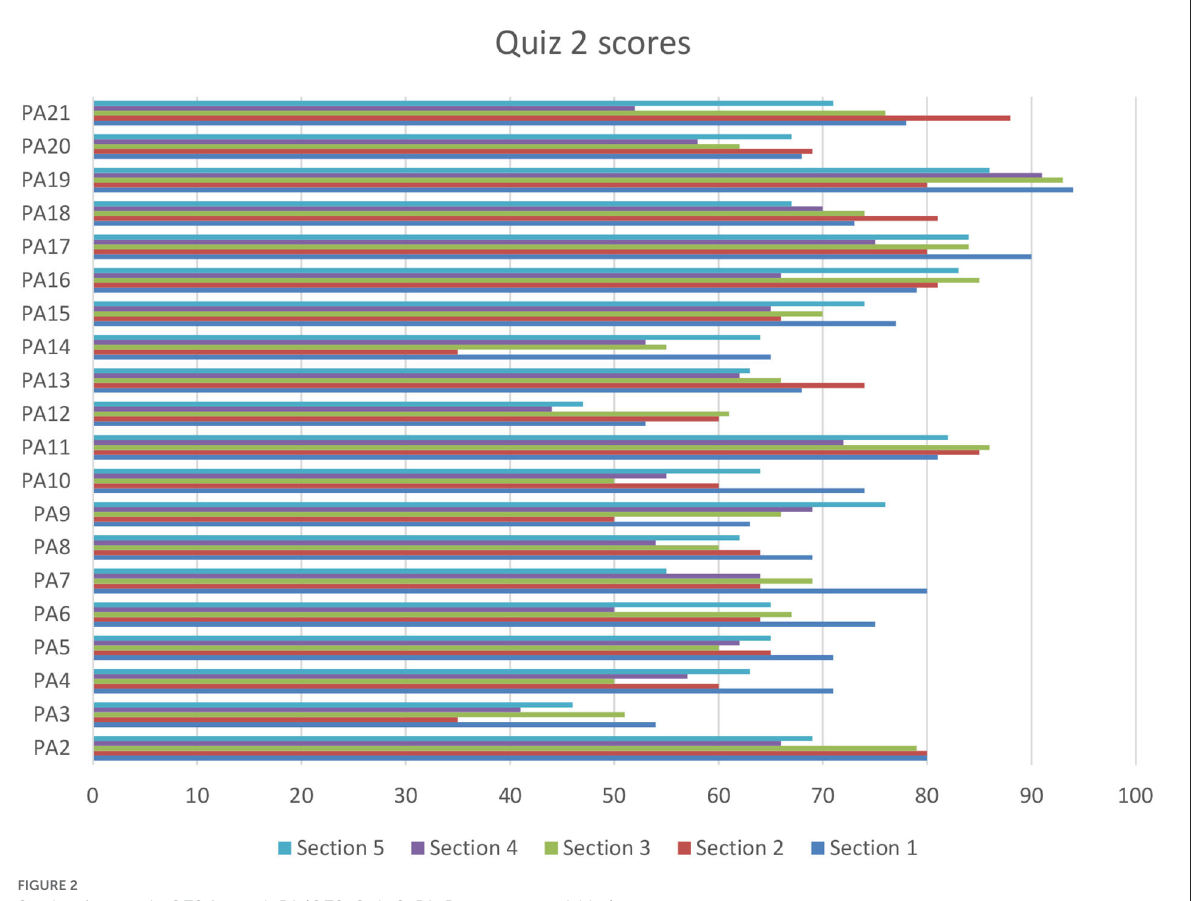
FIGURE2 Sections’ scores in QZ2 for each PA (QZ2, Quiz 2; PA, Preparatory